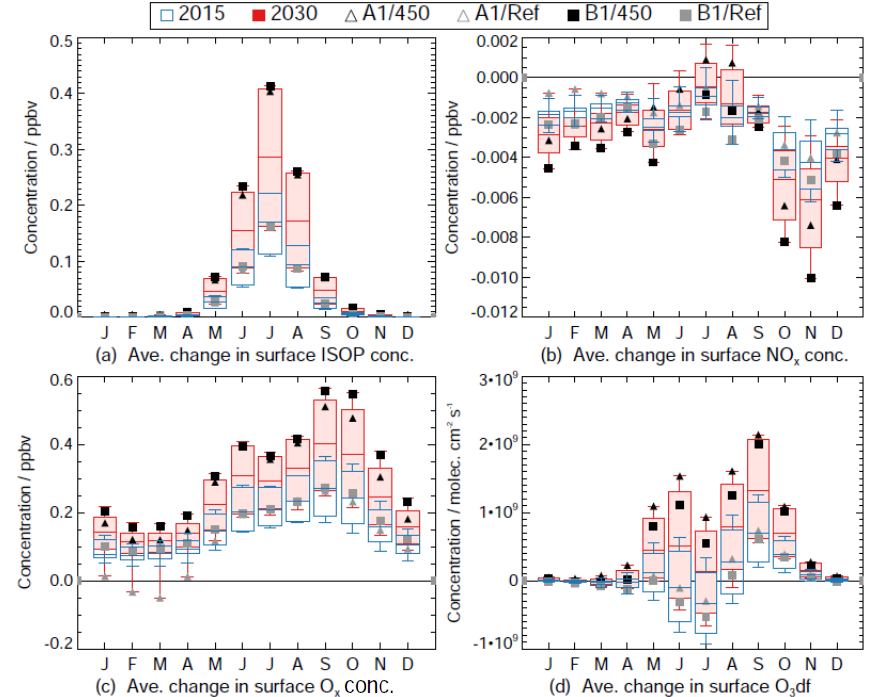
Fig. 14. Same as Fig. 7 but for boreal Eurasia (Fig.